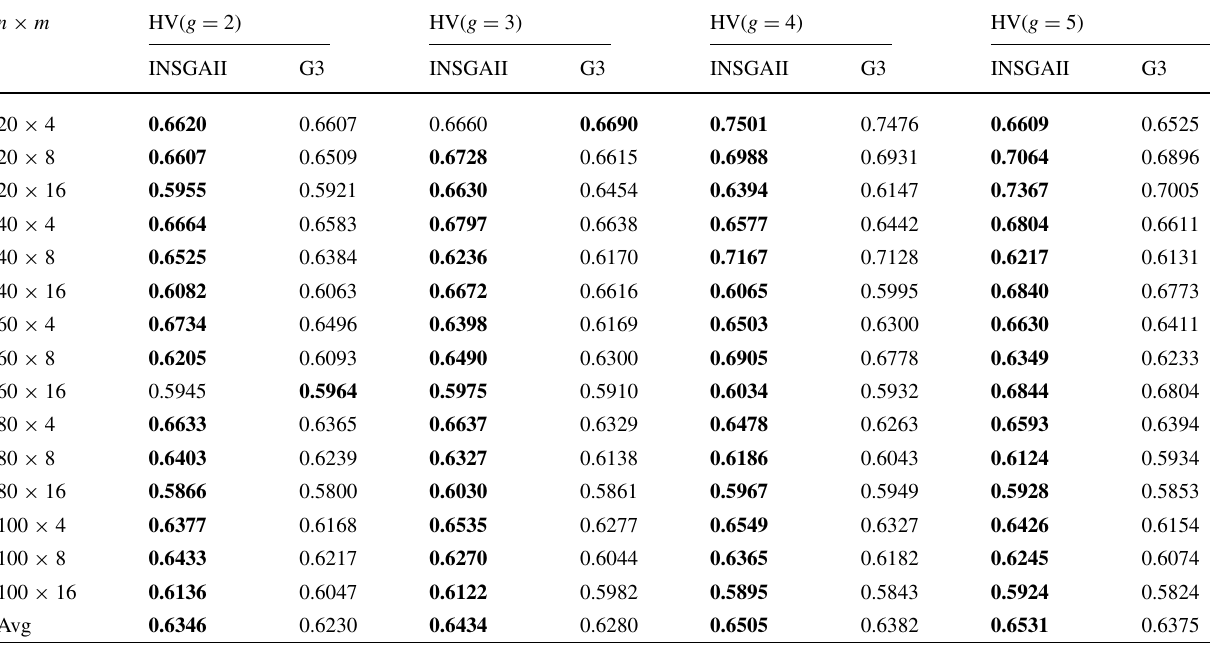
Table 8 Comparisons of the HV values between INSGAII and G3 n × m